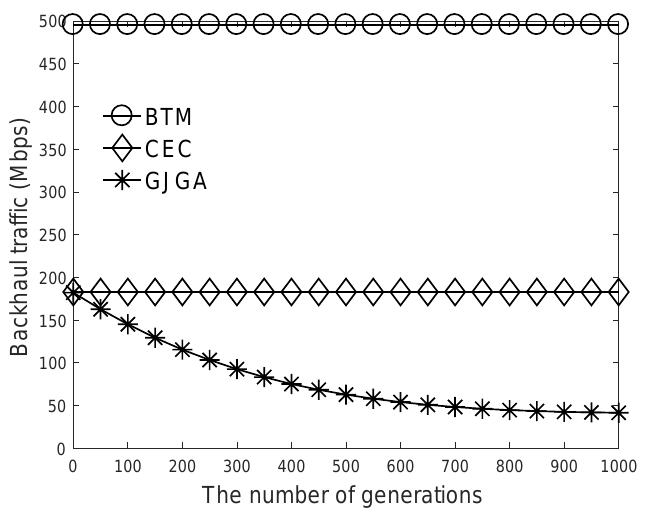
Figure 4. Effects of generations on the total backhaul traffic under 600 UEs, cache size of 4000, and 8000 files. Figure 4 evaluates the performance of the proposed algorithm for each